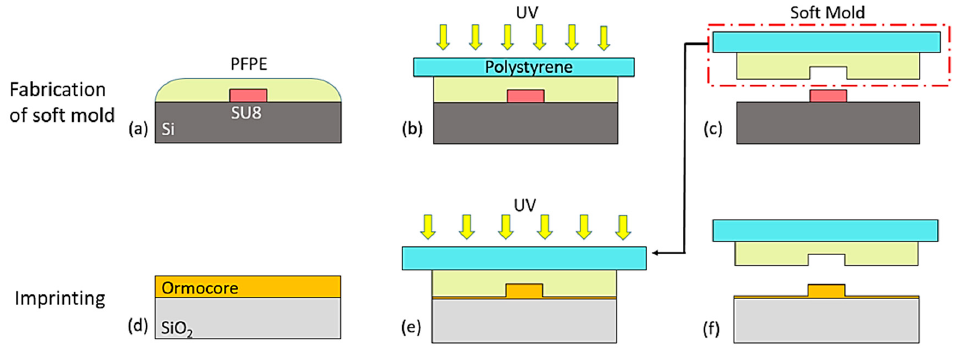
Figure 6. ( a – c ) are the fabrication processes of the PFPE soft mold; ( d – f ) are the imprinting processes. Figure 6. (a), (b), and (c) are the fabrication processes of the PFPE soft mold ; (d), (e), and (f) are the